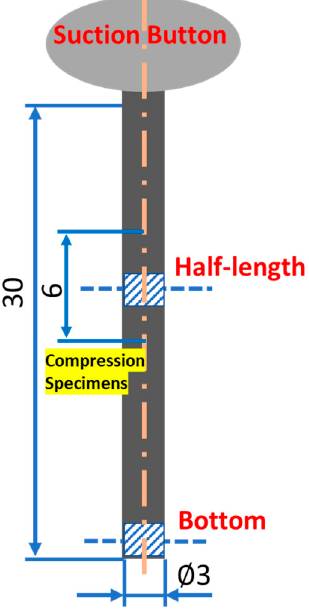
Figure 1. Schematic diagram showing the locations for metallography and compression test speci- mens.